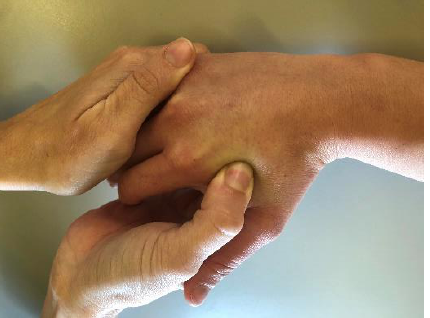
Figure 1. Ischemic compression over the MTrP of the